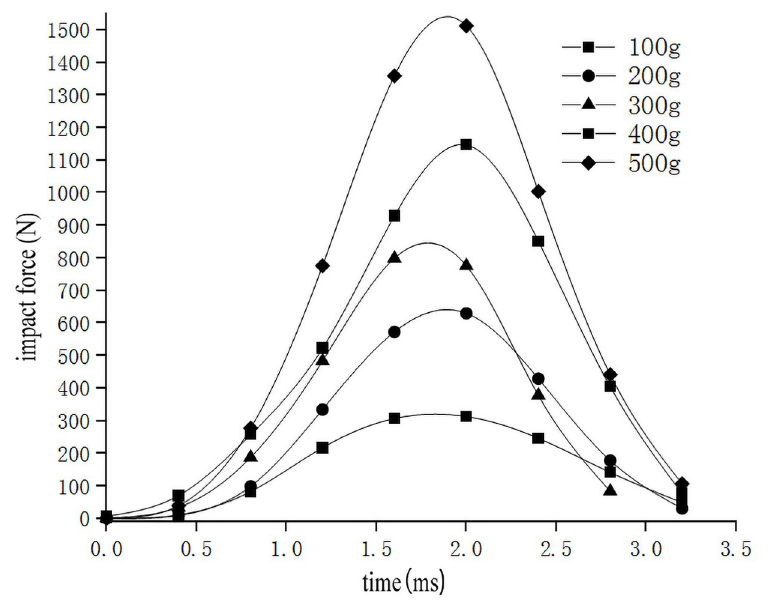
Fig 15. Impact force-time relationship of different sizes of sweet potato